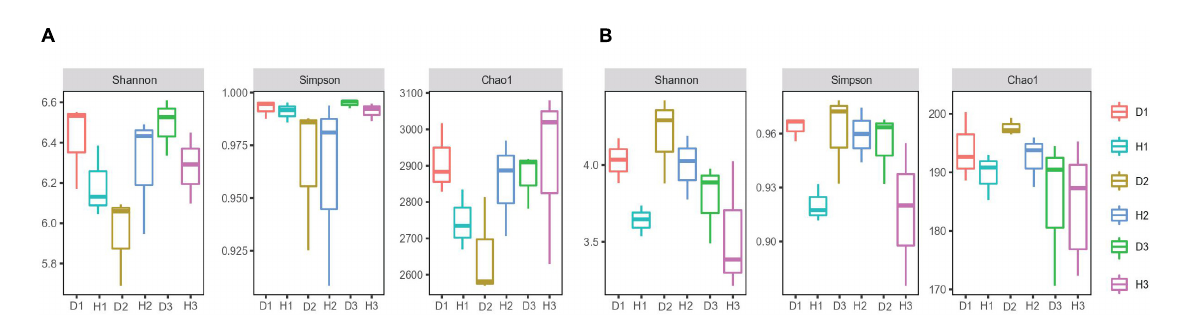
with Fusarium , Gibberella , Dactylonectria , Neonectria ,